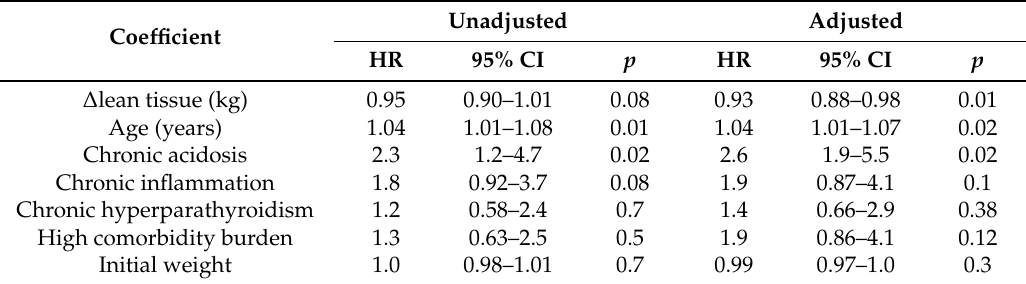
Table 4. Cox proportional hazards model to assess the association between some routinely collected parameters linked to malnutrition and risk of death, presenting hazard ratios (HR), 95% confidence intervals (CI) and p -values ( p